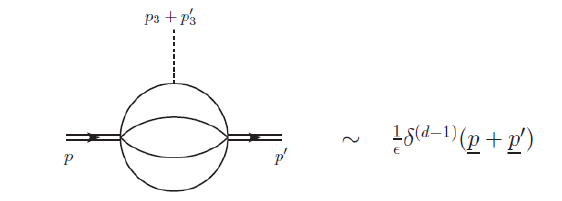
Figure 3 . A boundary contribution to the correlator of (cid:30) 4 in momentum space.